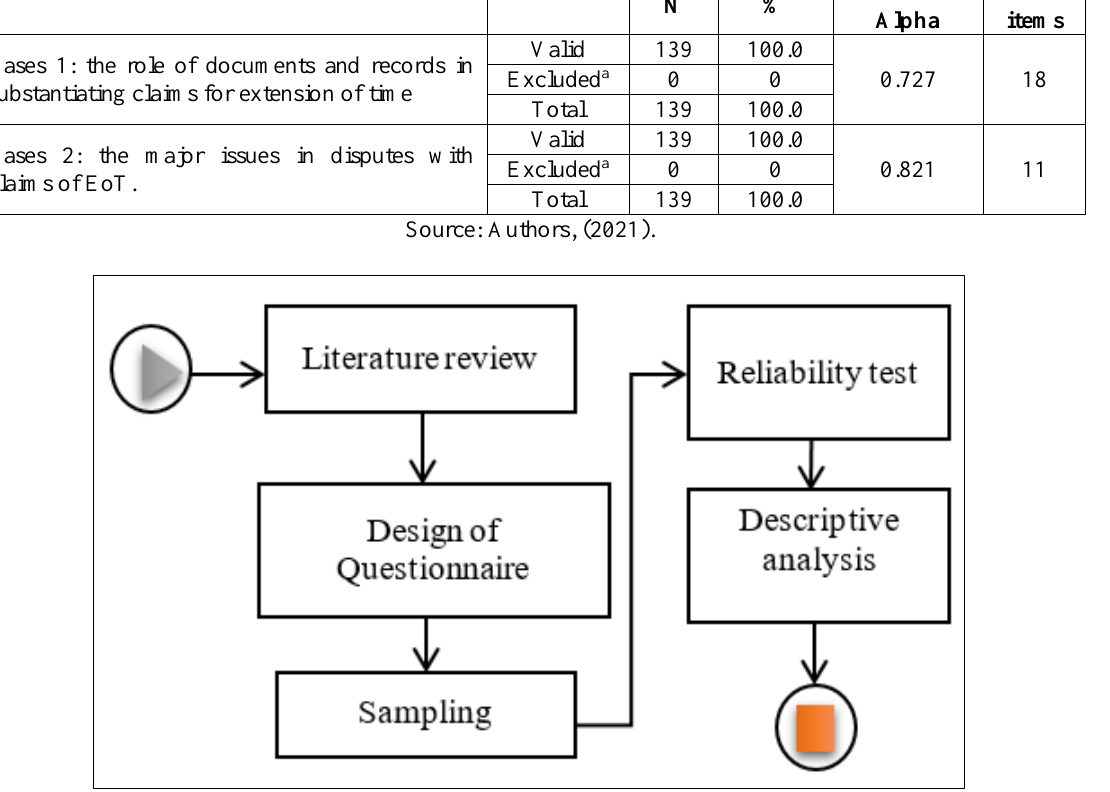
Figure 2: Methodological flow